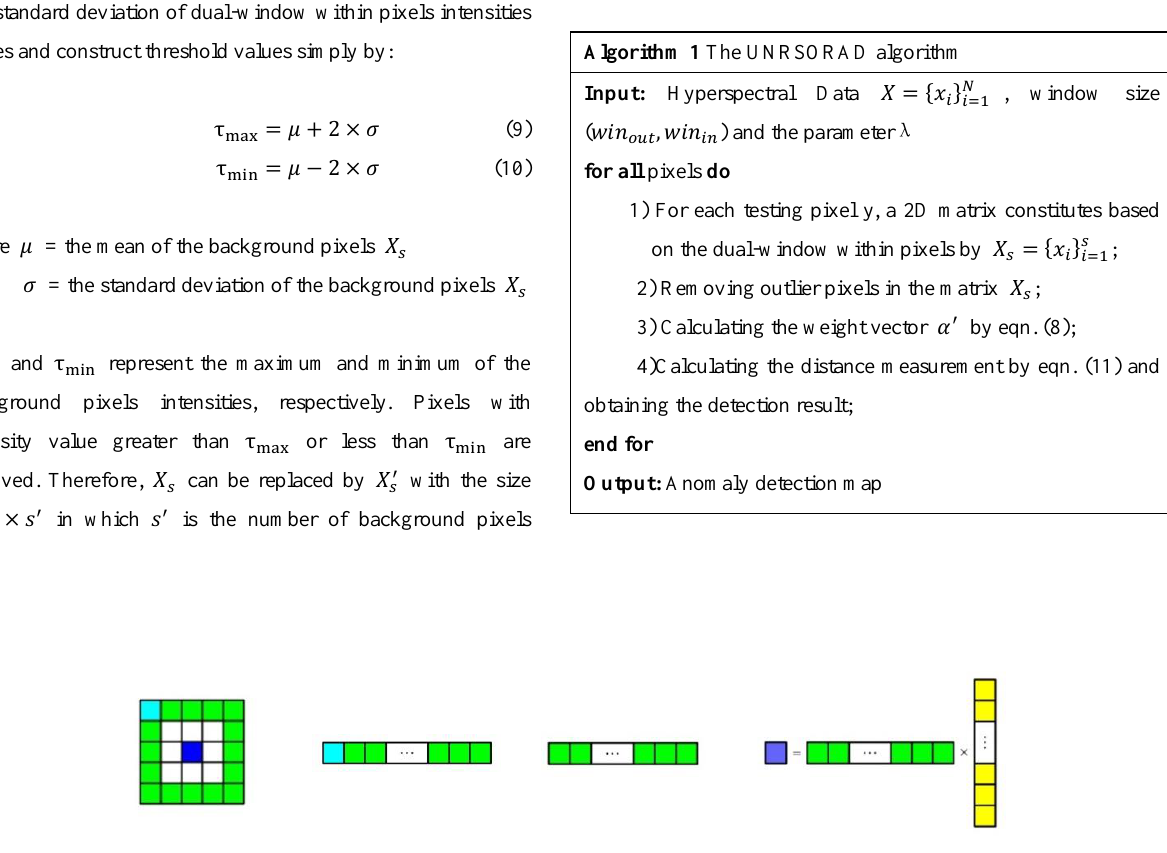
Fig. 2 outliers removal and liner representation